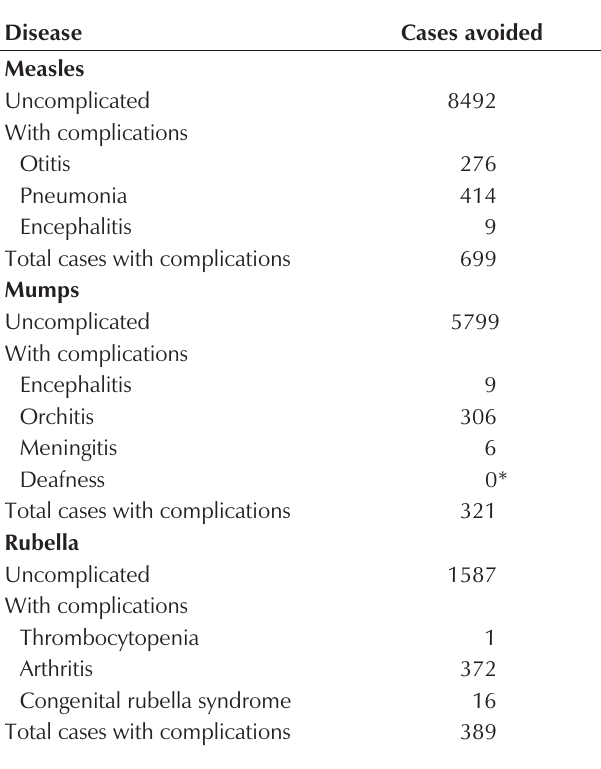
TABLE 3 Anticipated cases of disease in the absence of a routine sec- ond dose of measles, mumps and rubella vaccine (per 400,000 birth cohort)